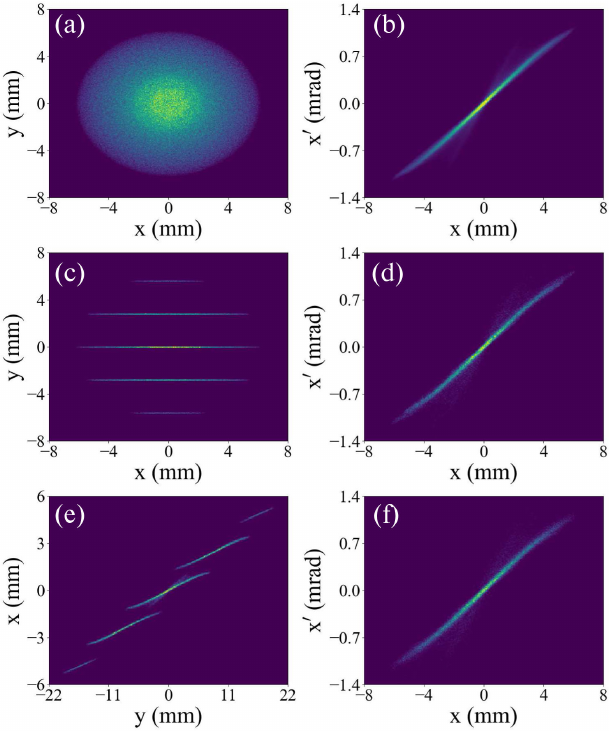
FIG. 7. Beam ’ s x - y (right) and x - x 0 (left) images taken at different locations are displayed. These are generated from start- to-end simulation. (a) and (b) are the images before a multislit. (c) and (d) are the images after the multislit. (e) is the x - y beam image at the end of the beam line. (f) is the reconstructed phase space image using data from (e). Here, the reconstruction target is